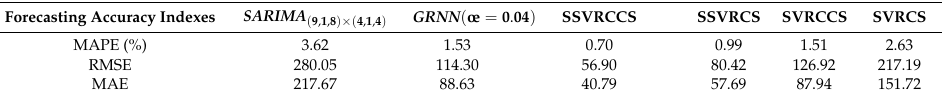
Table 3. Forecasting accuracy indexes of the compared models for Example 1.